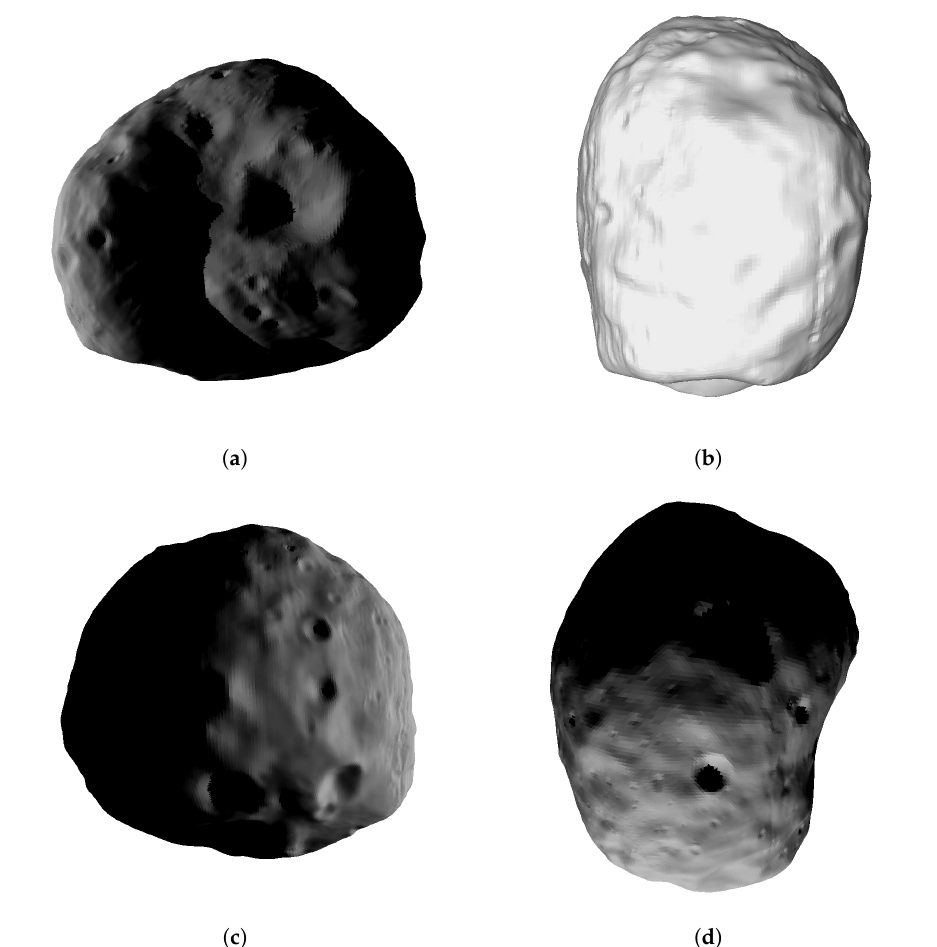
Figure 10. Solar illumination of Martian moon Phobos, showing realistic shadowing in different angles of view. ( a ) Phobos [17], solar radiation from the left-hand side; ( b ) Phobos [17], solar radiation from the front (directed into image plane); ( c ) Phobos [17], solar radiation from the right-hand side; ( d ) Phobos [17], solar radiation from the